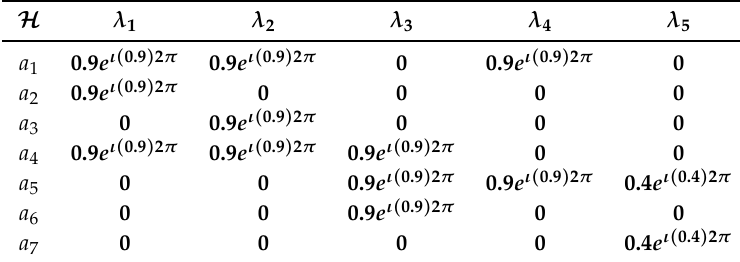
Table 2. Incidence matrix of N -tempered CNHG